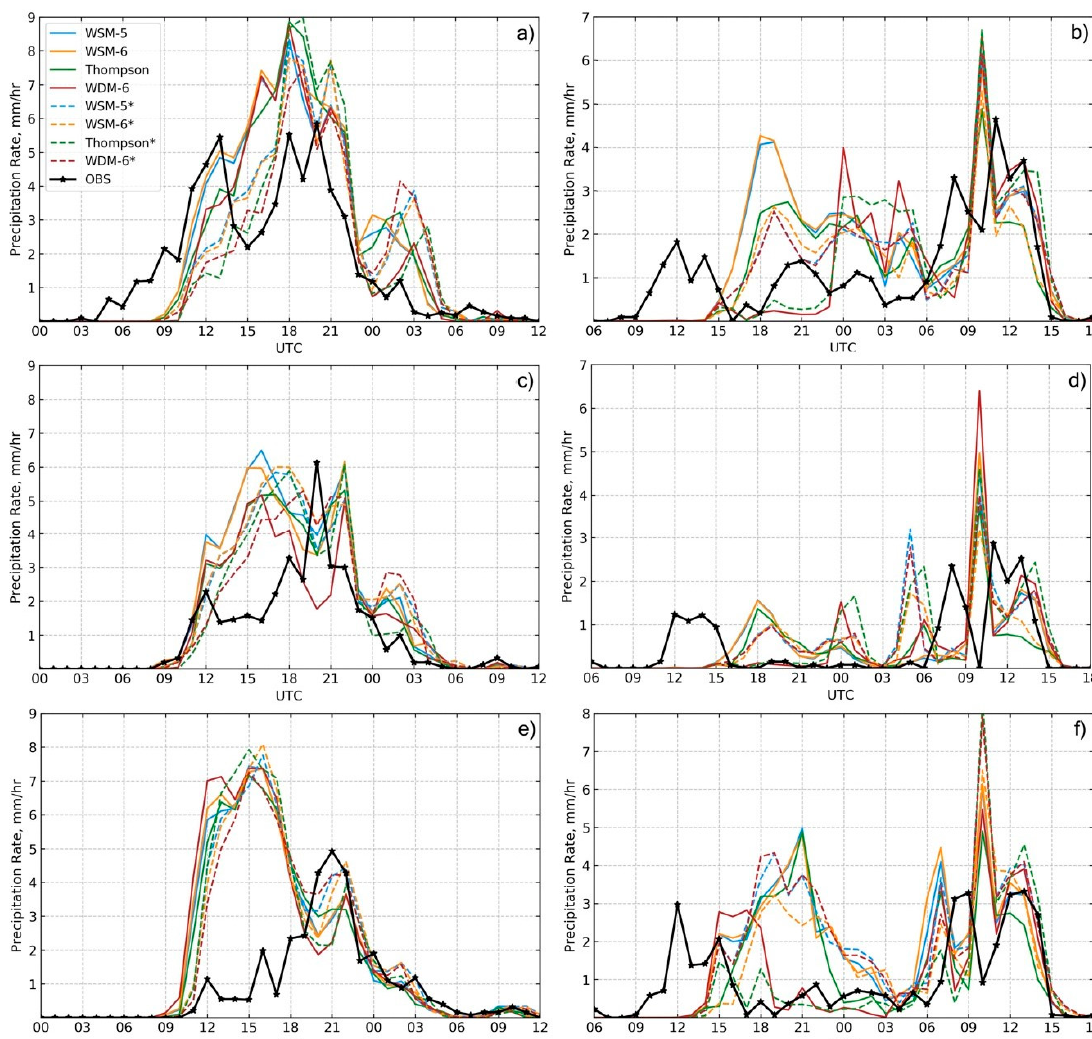
Figure 9. Zone average simulated and observed hourly precipitation rate for ( a , b ) Santa Cruz Mountains, ( c , d ) Valley Floor, and ( e , f ) Diablo Mountains; ( a , c , e ) atmospheric rivers (AR1), and ( b , d , f ) AR2. * denotes 1/3 km resolution.